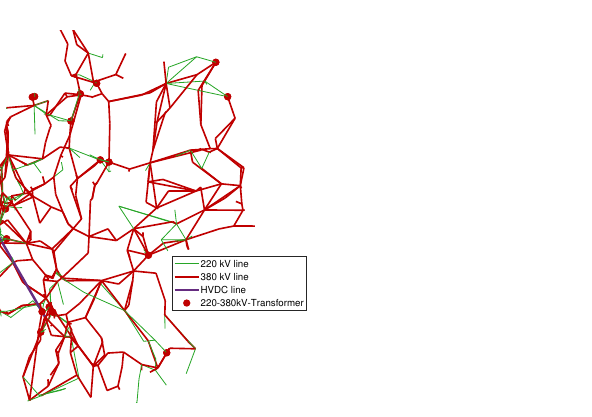
Figure 4. Representation of the German transmission grid with 575